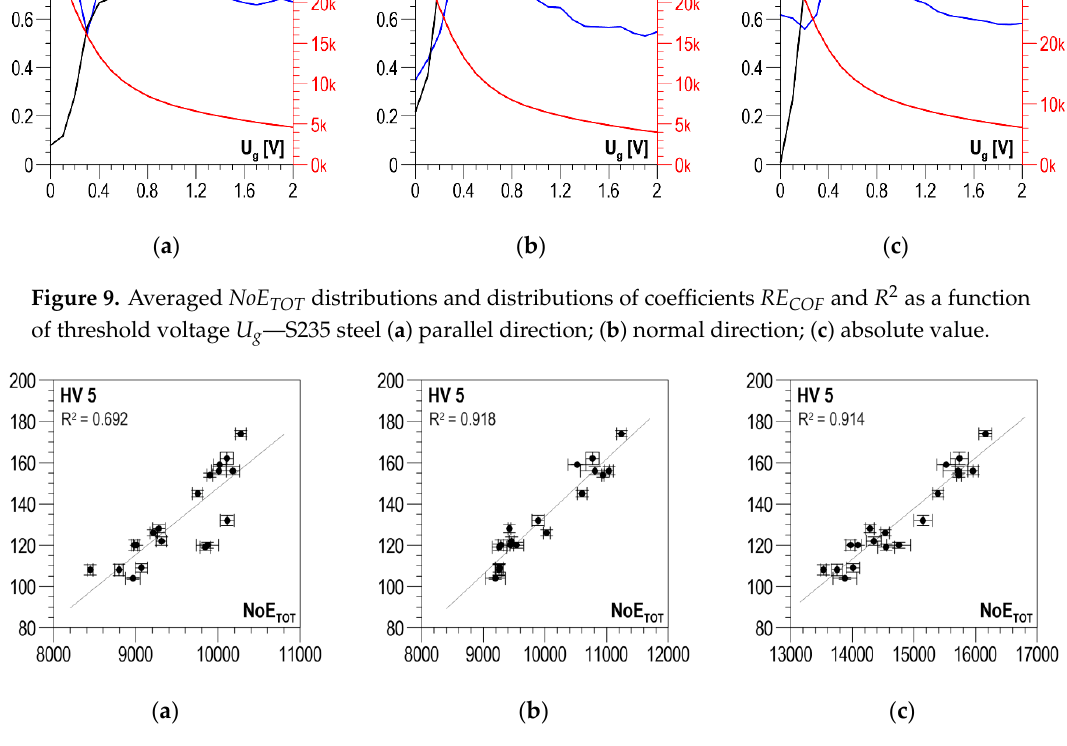
Figure 10. Linear correlations between NoE TOT and HV5 hardness – S235 steel ( a ) parallel direction, U g = 0.6 V; ( b ) normal direction, U g = 0.5 V; ( c ) absolute value, U g = 0.5 V.